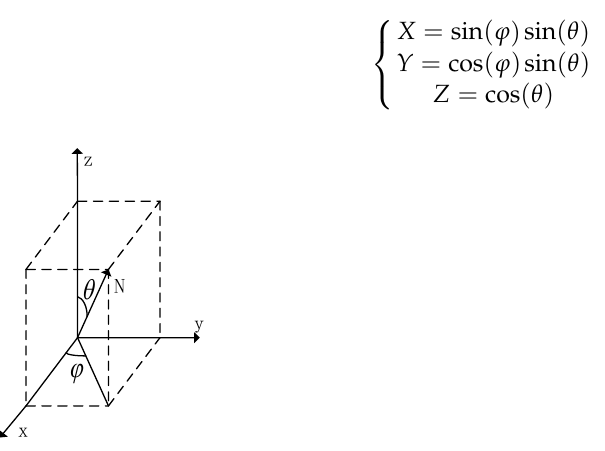
Figure 2. Polar coordinate representation of normal vector.